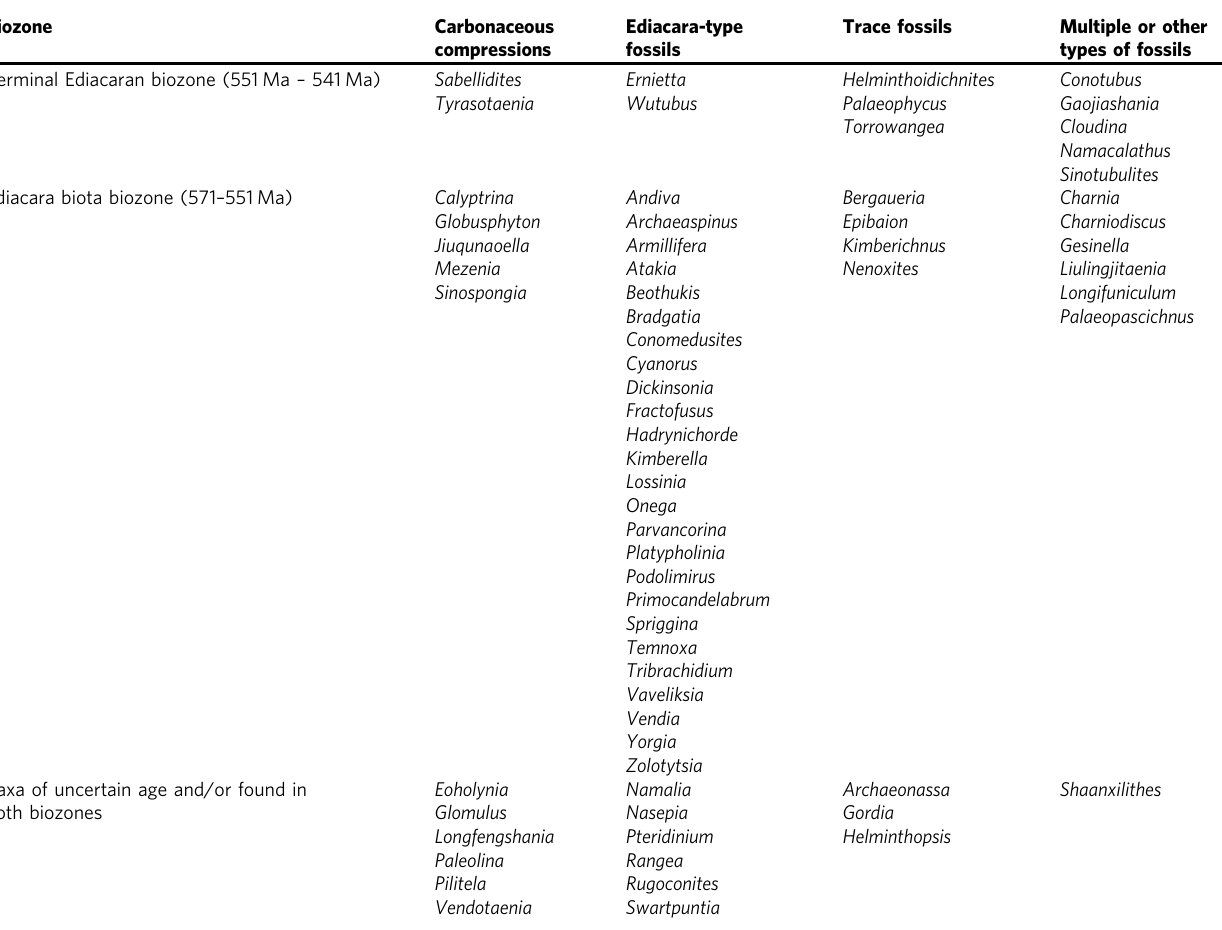
Table 2 Ediacaran stage-level biozones and their diagnostic taxa